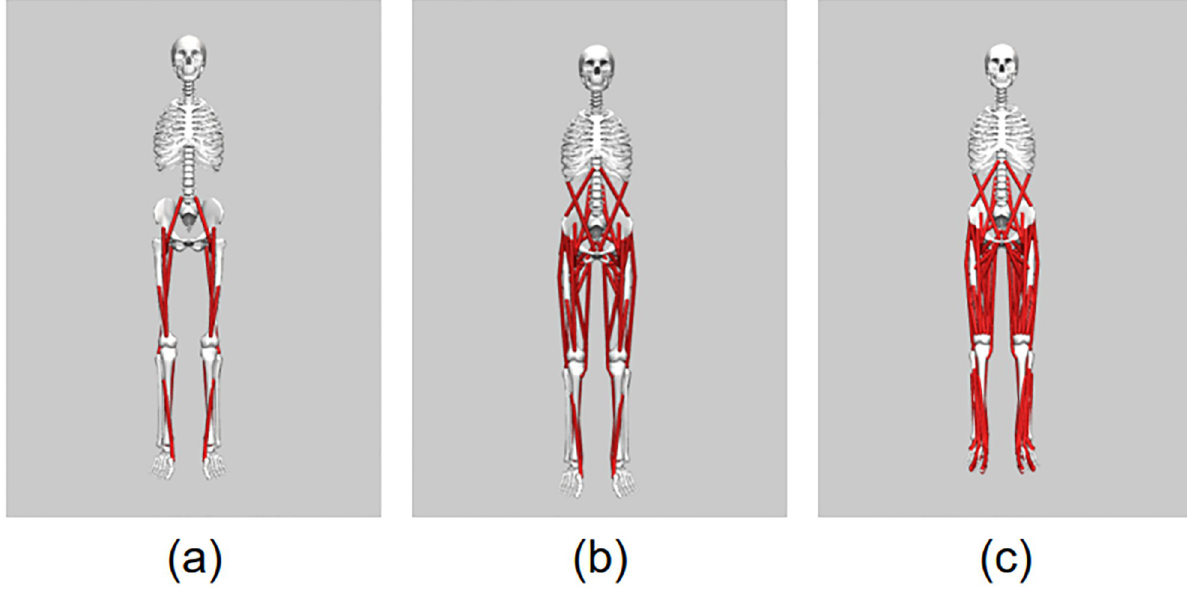
Fig 2. The three musculoskeletal models that are used throughout the simulations of this work. They appear in order of increasing complexity from left to right. (a) The “Human0916”, (b) “Gait2354”, and (c) “Gait2392” model.